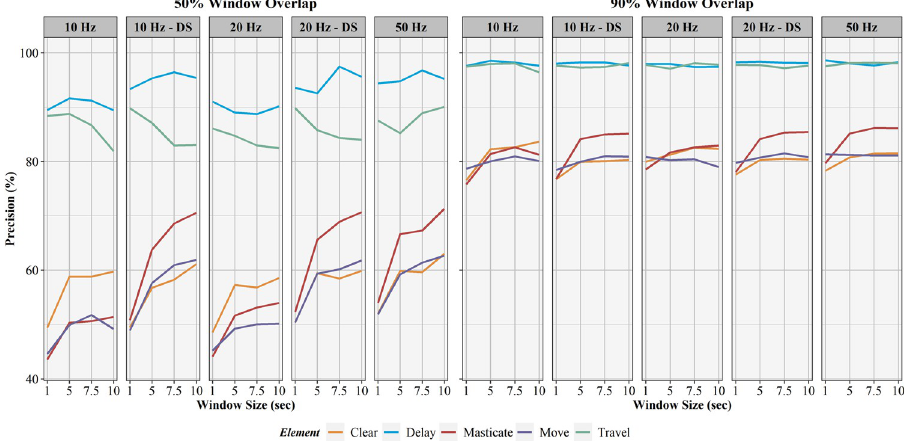
Fig 8. Precision results for activity recognition models. Comparison of activity recognition model precision percentages for 50% and 90% sliding window overlaps across the four sliding window lengths (1, 5, 7.5, 10 seconds) for each work element (clear, delay, masticate, move,